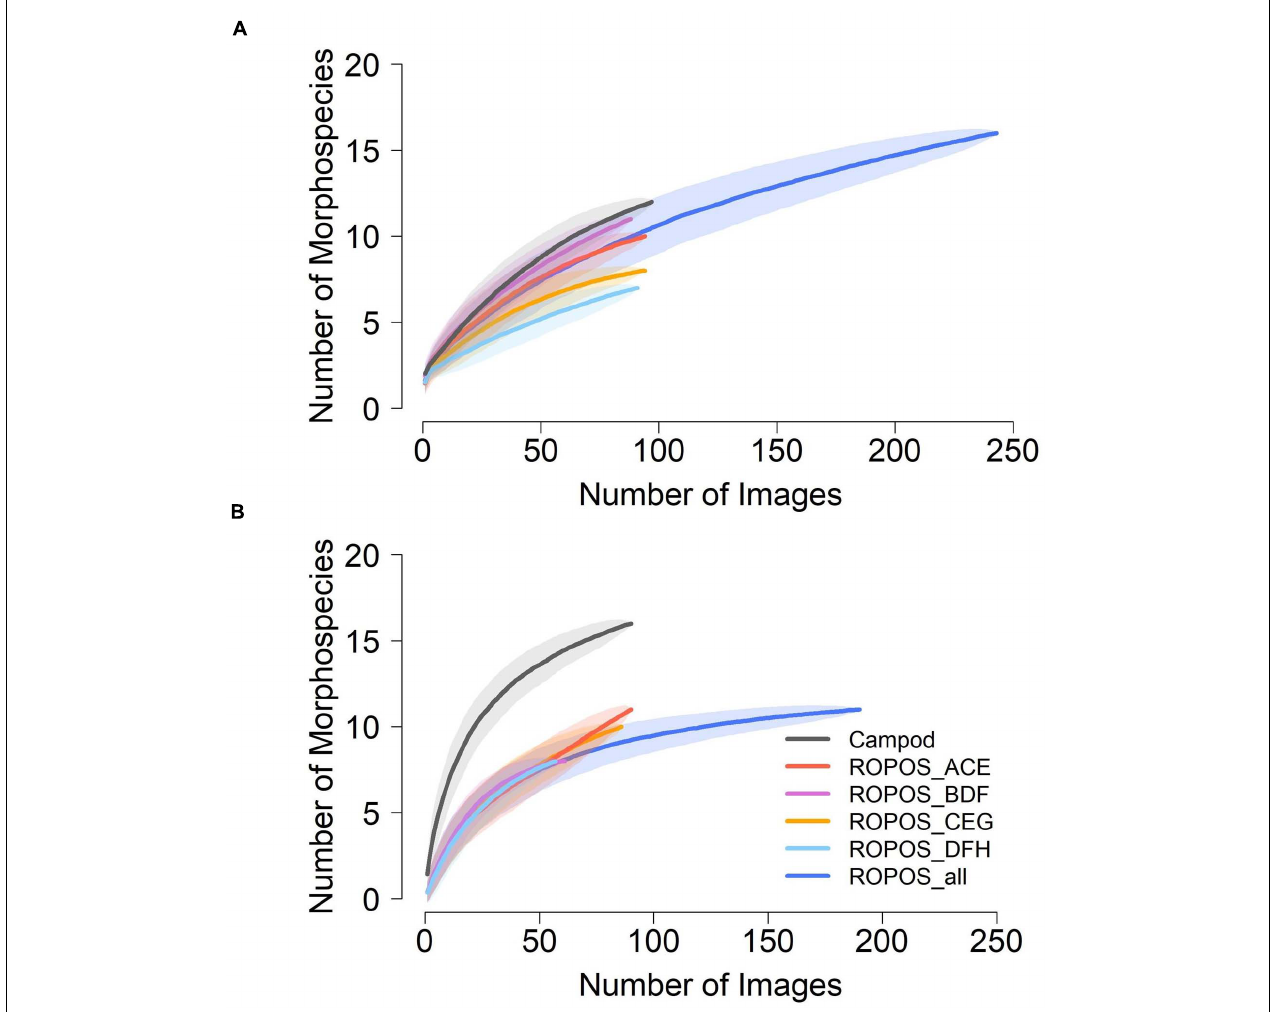
FIGURE 6 | Morphospecies accumulation curves at (A) station LC2 and (B) station LC5 in the Laurentian Channel MPA, based on abundance per photo across each of the six sampling designs; Campod, ROPOS_ACE, ROPOS_BDF, ROPOS_CEG, ROPOS_DFH (3 400 m transects), and ROPOS_all (8 400 m transects). Used random method with 999 permutations; shaded confidence interval are one